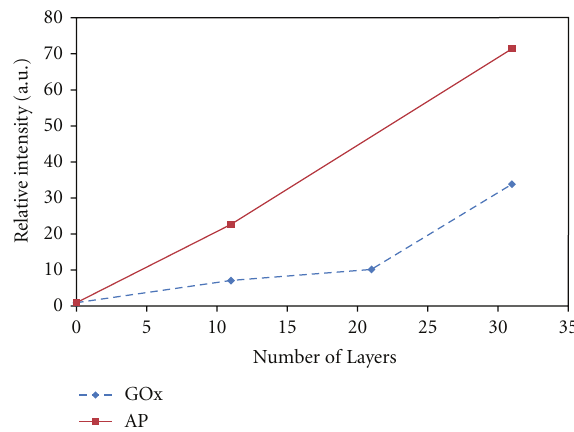
Figure 7: Plot of the relative intensity of chemiluminescent signal obtained from chips addressed with 0, 11, 21, and 31 layers of 200 nm biotin NPs and GOx-avidin or 0, 11, and 31 layers with